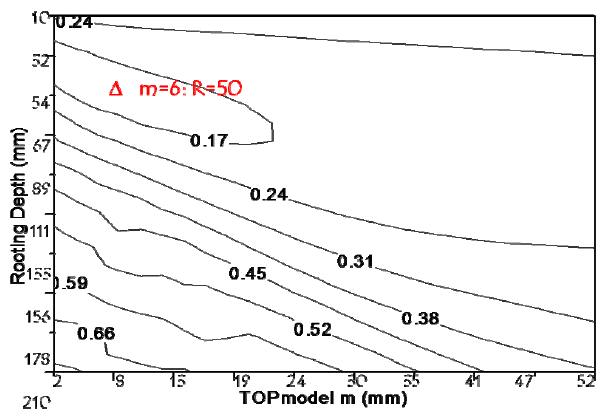
Fig. 4b. Average normalised departure averaged across five test catchments from their individual minimum RMS error. 1 shows Figure 3a. RMS mean difference between observed and simulated exceedance curves for R. global Hozgarganta, S. Spain. ∆ shows catchment optimum